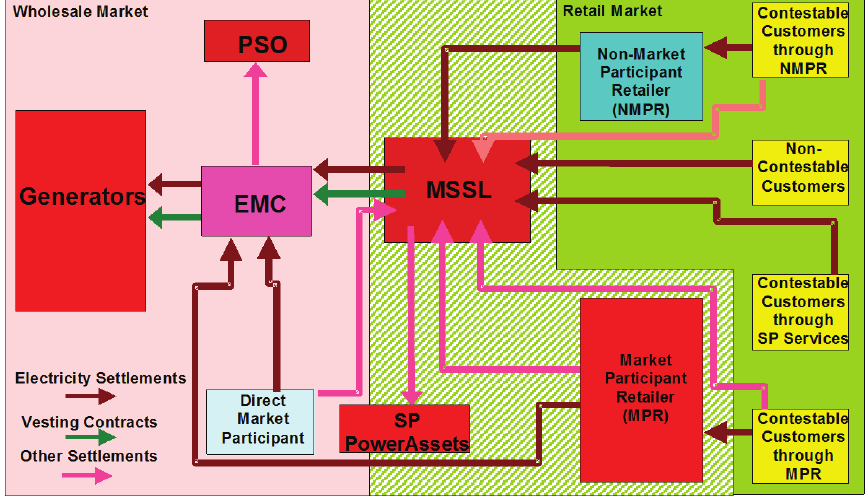
Figure 2. New Electricity Market of Singapore (NEMS) governance